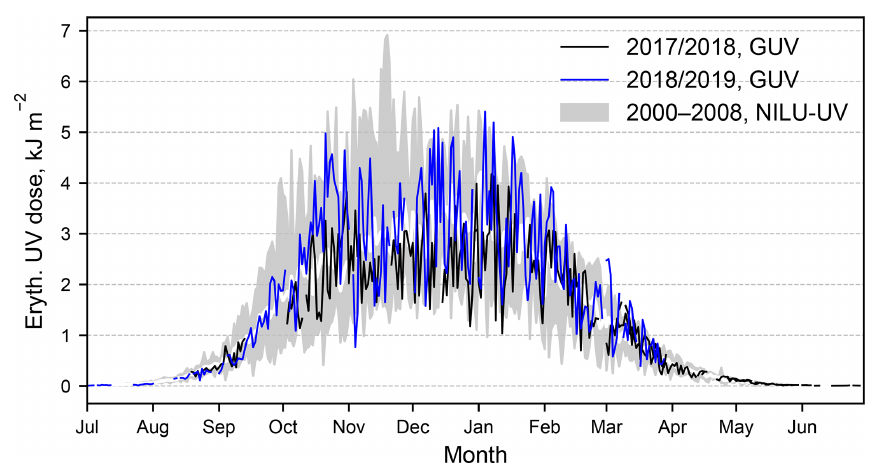
Figure 7. Comparison of daily erythemal UV doses from GUV measurements in Marambio in seasons 2017/2018 (black line) and 2018/2019 (blue line) with long-term measurements (2000–2008). The white line is the long-term (2000–2008) mean, and the grey area is set between long-term maxima and minima for each day.